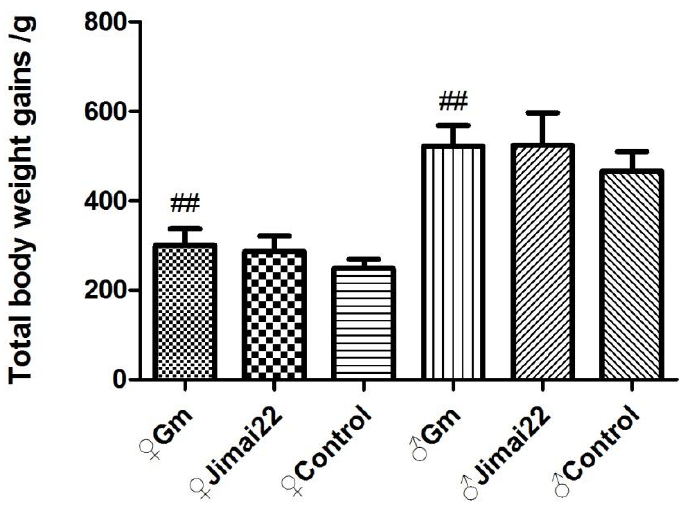
Figure 3. Total body weight gains of females and males during 13 weeks. ## represents p < 0.01 compared with control group.